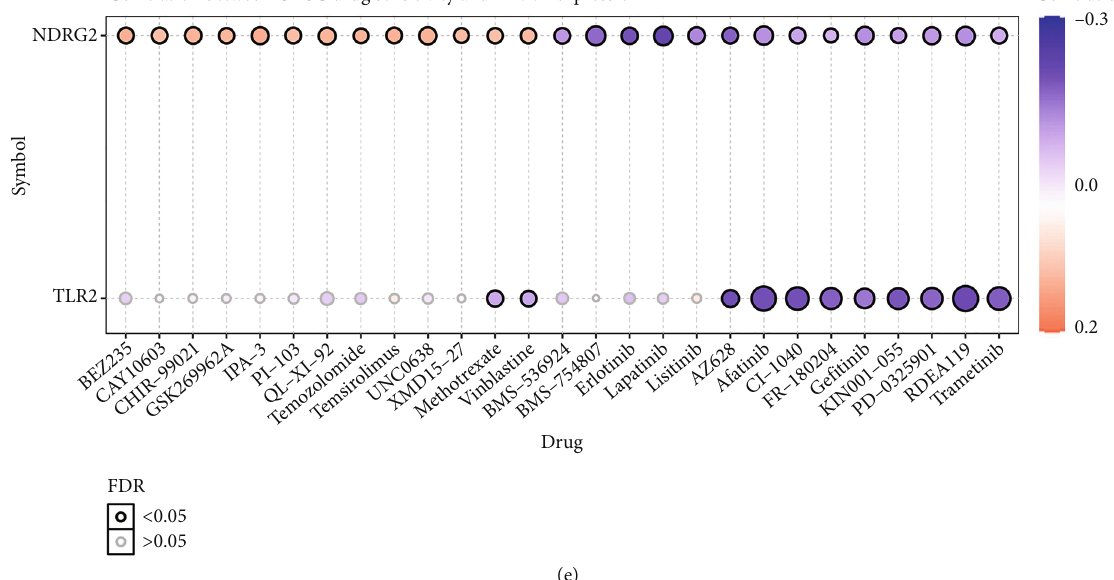
Figure 6: Necroptosis-related genes correlated with pathological stage, immune in fi ltration, and drug resistance in LUAD. (a) The correlation between pathological stage and TLR2, NDRG2, ALDH2, and HMGB1 in LUAD. (b) The correlation between immune cell in fi ltration and TLR2/NDRG2 in LUAD. (c) The correlation between copy number alteration of TLR2/NDRG2 and immune cell in fi ltration in LUAD. (d) The correlation between TLR2/NDRG2 expression and TMB score as well as MSI score in LUAD. (e) The correlation between TLR2/NDRG2 expression and GDSC drug sensitivity. TMB, tumor mutation burden; MSI, microsatellite instability; GDSC, Genomics of Drug Sensitivity in